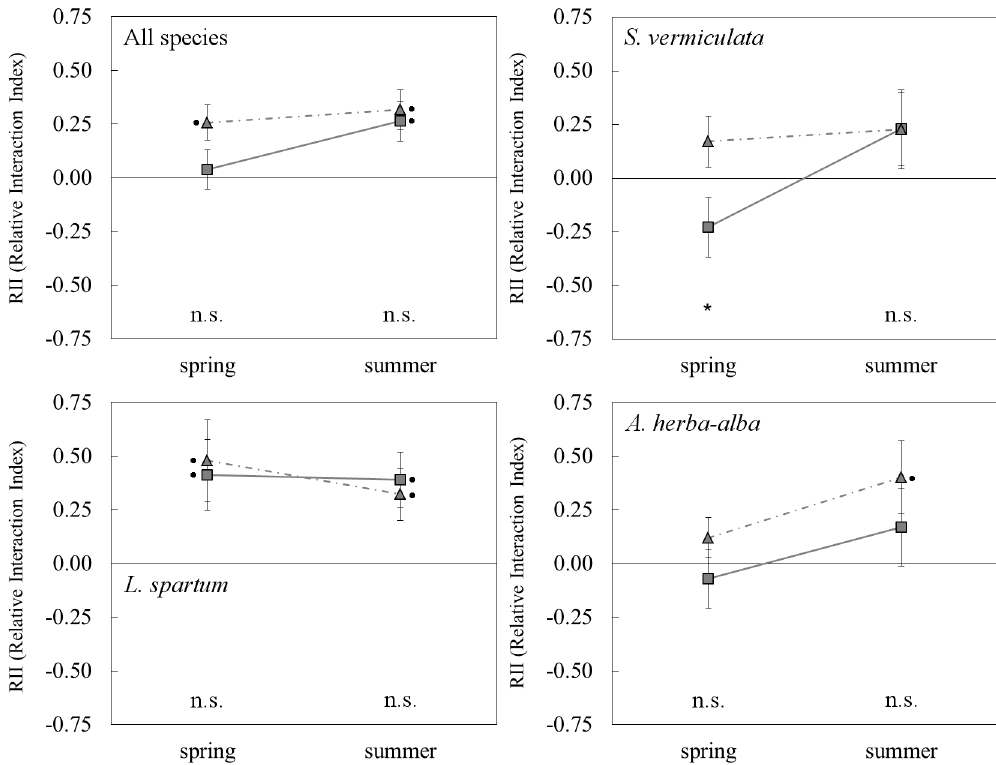
Fig 5. Net interaction outcome (RII; mean ± SE) of shrub microsites in spring and summer. Square and triangle symbols indicate RII values calculated for the vitality of juveniles in A . herba-alba and S . vermiculata microsites respectively. Black dots indicate RII values significantly different from zero (t-test, p < 0.05). n.s., not significant; (cid:3) , p < 0.05.